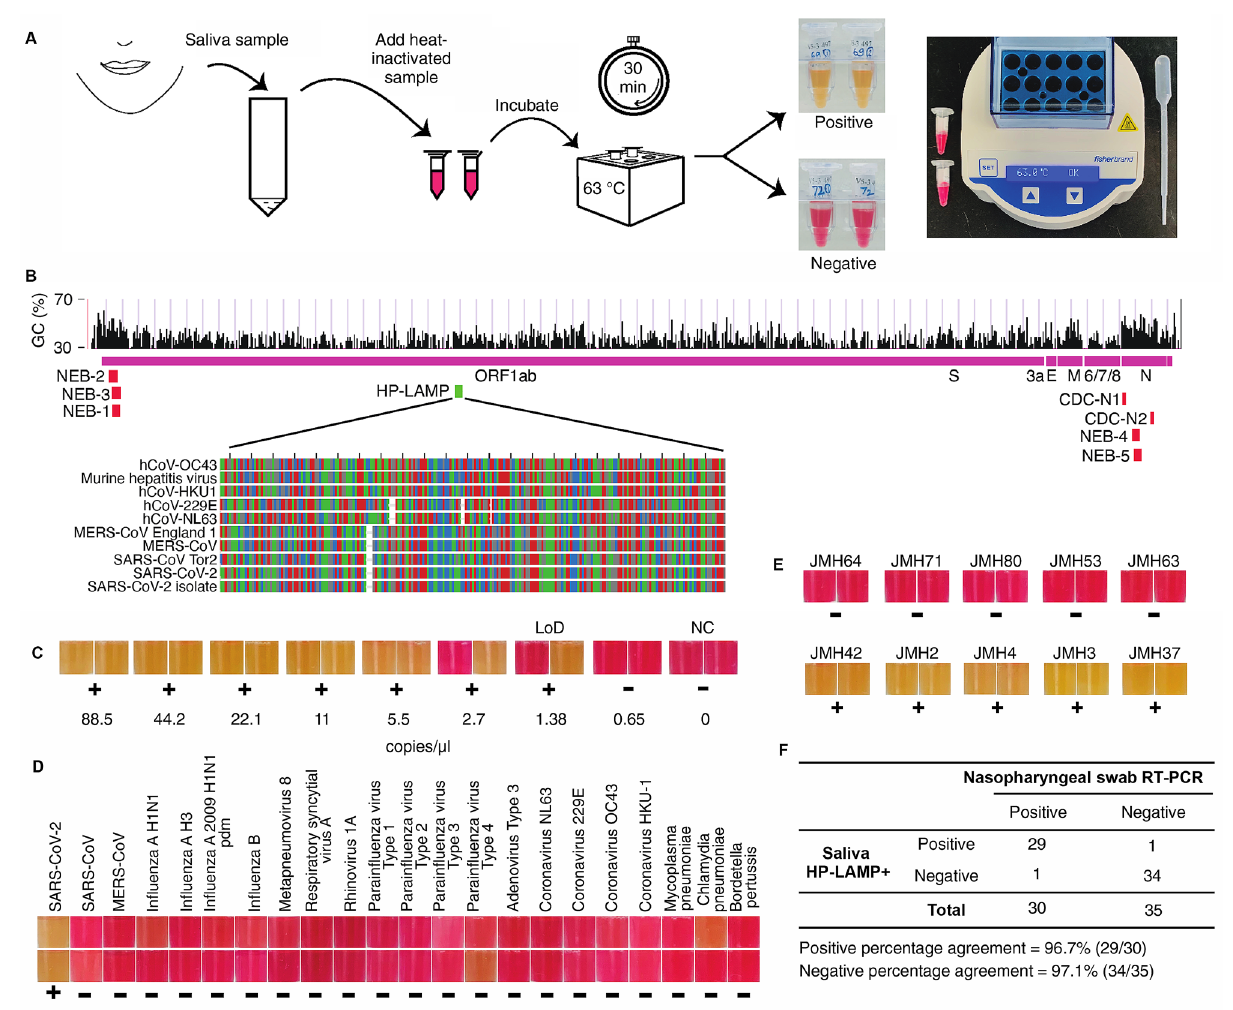
Figure 2. ( A ) HP-LAMP assay workflow. Heat-inactivated saliva (5 µl) was added to each of the two 1.5 ml microcentrifuge tubes pre-filled with the reaction mixture, incubated at 63°C for 30 min and then visualized for colorimetric change (yellow = positive; red = negative). At least one out of two tubes must turn yellow to interpret the assay result as positive. The minimum equipment needed to run the assay is a disposable transfer pipette, 2 heat blocks, and microcentrifuge tubes prefilled with reaction mixture. No prior RNA extraction or treatment is required. ( B ) Genome map showing targeted region of primers used for HP-LAMP in green. Locations of primers and probes from the CDC 2019-nCoV Real-Time RT-PCR Diagnostic Panel/New York SARS-CoV-2 Real-time RT-PCR Diagnostic Panel, and the New England Biolabs’ (NEB) SARS-CoV-2 assay are indicated in Red. Whereas previously used primers and probes targeted the GC-rich regions located at the 5 ′ and 3 ′ ends of the viral RNA, the primers used for HP-LAMP target the central portion of the viral RNA, which is better protected from digestion by salivary exonucleases. The targeted region of the HP-LAMP primer set with alignments of other Betacoronavirus genomes are featured 29,15 . Each nucleotide is shown (A: green; G: gray; T: red; C: blue). The percentage of GC-content across the genome is indicated (http://genom e.ucsc.edu) 30,16 . ( C ) Determining the limit of detection (LoD) of the HP-LAMP assay. The concentrations indicated show copies of heat-inactivated SARS-CoV-2 per µl of saliva. NC = negative control with no SARS-CoV-2 added. ‘ + ’ = Positive HP-LAMP result; ‘-’ = Negative HP-LAMP result. The color of each box is taken directly from its corresponding reaction tube. ( D ) Cross-reactivity of HP-LAMP assay on common pathogens. Inactivated known respiratory pathogens (n = 21) along with inactivated SARS-CoV-2 virus were tested using HP-LAMP assay. All pathogens showed negative detection results in HP-LAMP assay, expect for SARS-CoV-2 virus. ( E ) Representative results of HP-LAMP testing on clinical samples. ( F ) Table shows positive and negative percentage agreement of HP-LAMP for detection of SARS-CoV-2 in saliva compared with nasopharyngeal swab RT-PCR